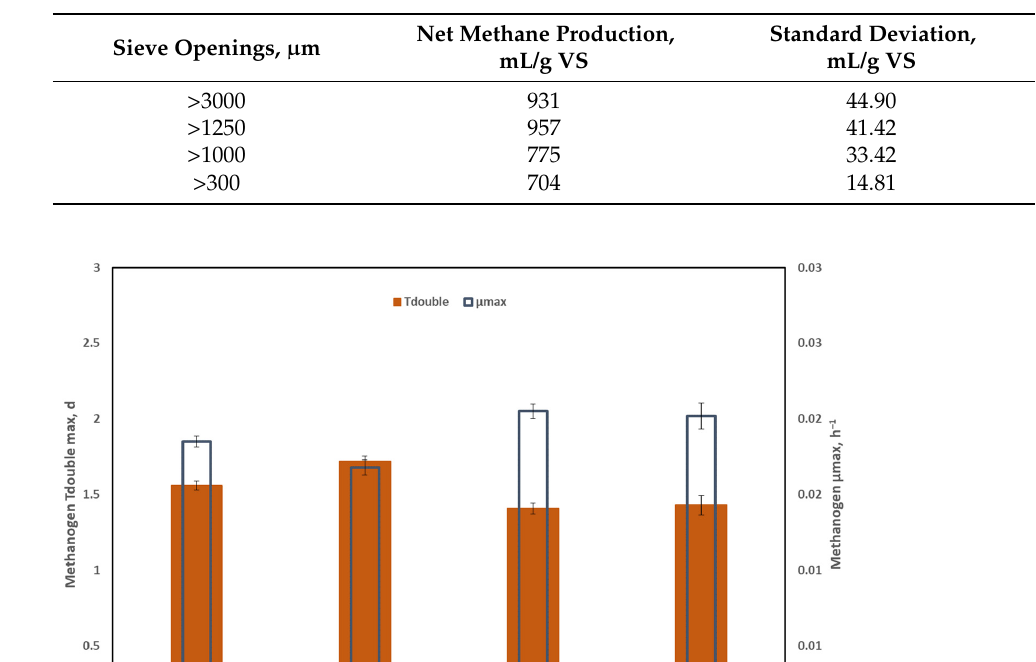
Table 2. Total net methane production for the cumulative solid fractions collected from sieves with certain opening sizes, in mL/g VS.